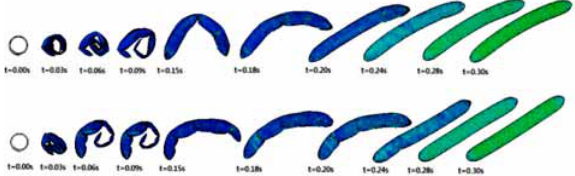
Fig. 14. Equivalent stress distortion in the inflation process of a rolled model. Model C is at the top while model D is at the bottom The element size contrast of the inner and outer mesh with and without correction is shown in (Fig.